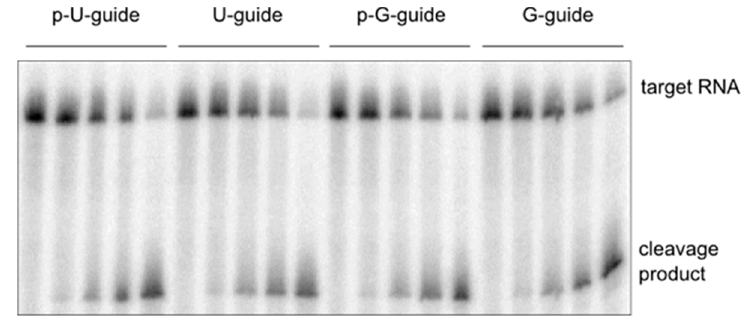
Figure 5. hAgo2-mediated cleavage of target RNA with guide strands carrying either a 5’-uridine or a 5’-guanosine with or without a 5 ′ -phosphate. Cleavage assays were conducted using 2.5 µM hAgo2, 100 nM guide RNA (as2b or G-as2b) and 2.5 nM target RNA (ICAM-1-IVT). Samples were taken at time points 0', 5', 25', 55', and 120' and analyzed using 8% denaturing PAGE. Detection was carried out via autoradiography.